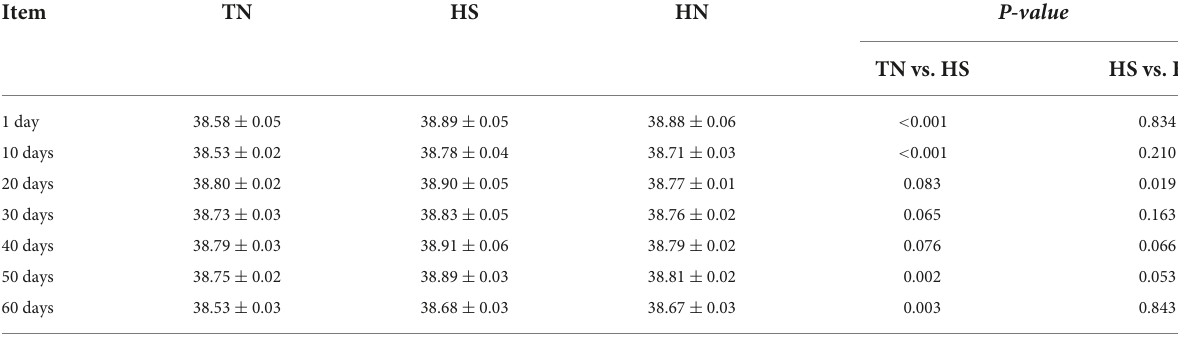
TABLE 2 Effects of niacin on the body temperature of beef cattle under heat stress ( ◦